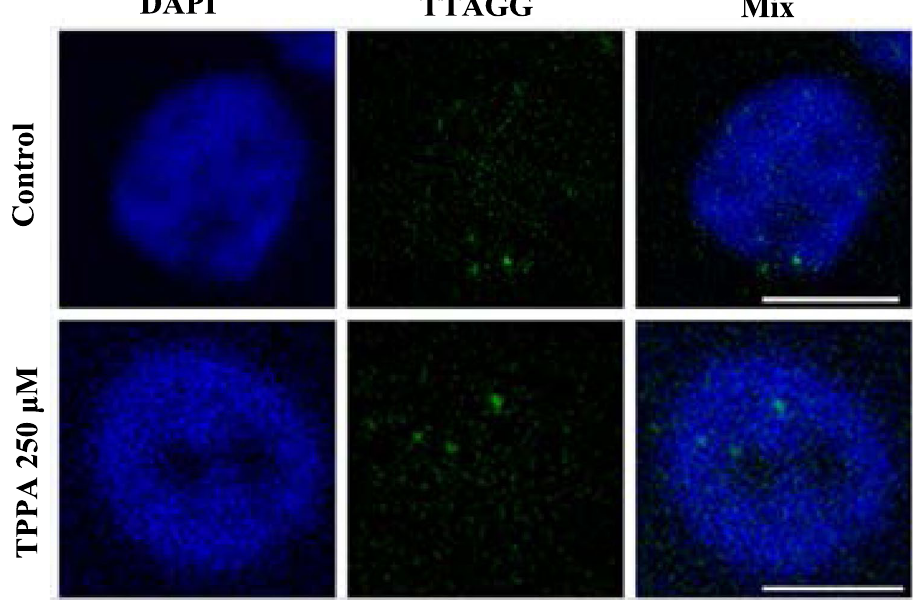
Figure 2. DNA-FISH of control and drug treated wing discs. The drug treated and control wing disc nuclei show condensed 5 ′ -TTAGG-3 ′ satellite DNA. No change was detected in the number of TTAGG signals observed between control and drug treated nuclei. DNA was visualized by DAPI staining. Scale bar, 10 µ